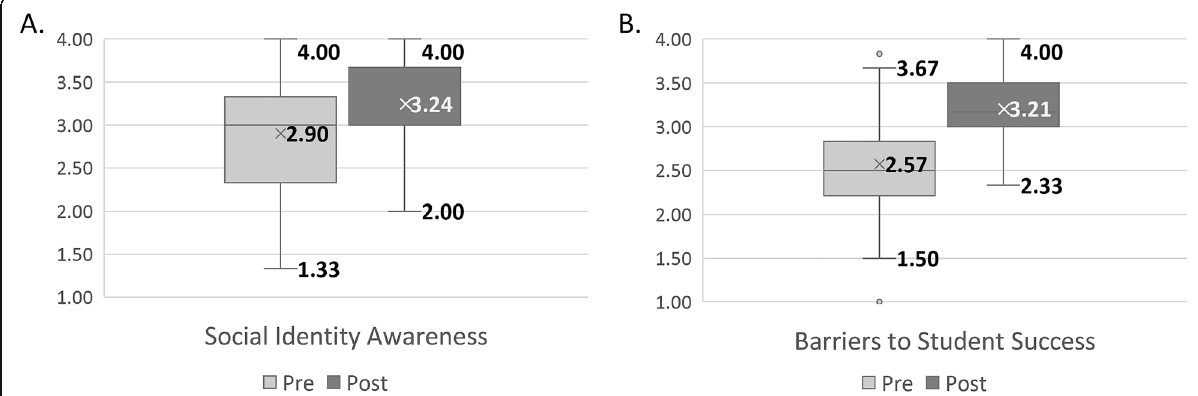
Fig. 1 Workshop participant change in knowledge based on factor analysis of pre- and post-survey responses. a Awareness of social identities ( N = 71: Mean pre = 2.90, SD pre = 0.66; Mean post = 3.24, SD post = 0.46). b Barriers to student success in the classroom ( N = 68: Mean pre = 2.57, SD pre = 0.57; Mean post = 3.21, SD post = 0.41). For each factor, a paired samples t test indicates that the mean post-survey scores are significantly higher than the mean pre-survey scores ( p < 0.001). Each box corresponds to the interquartile range of mean scores, the “ x ” corresponds to the mean score for each latent construct, the horizontal line inside each box to the median, and the dots ( b ) to outliers in the dataset. Means are derived from Likert scale values: 1, not at all knowledgeable; 2, somewhat knowledgeable; 3, knowledgeable; 4, highly